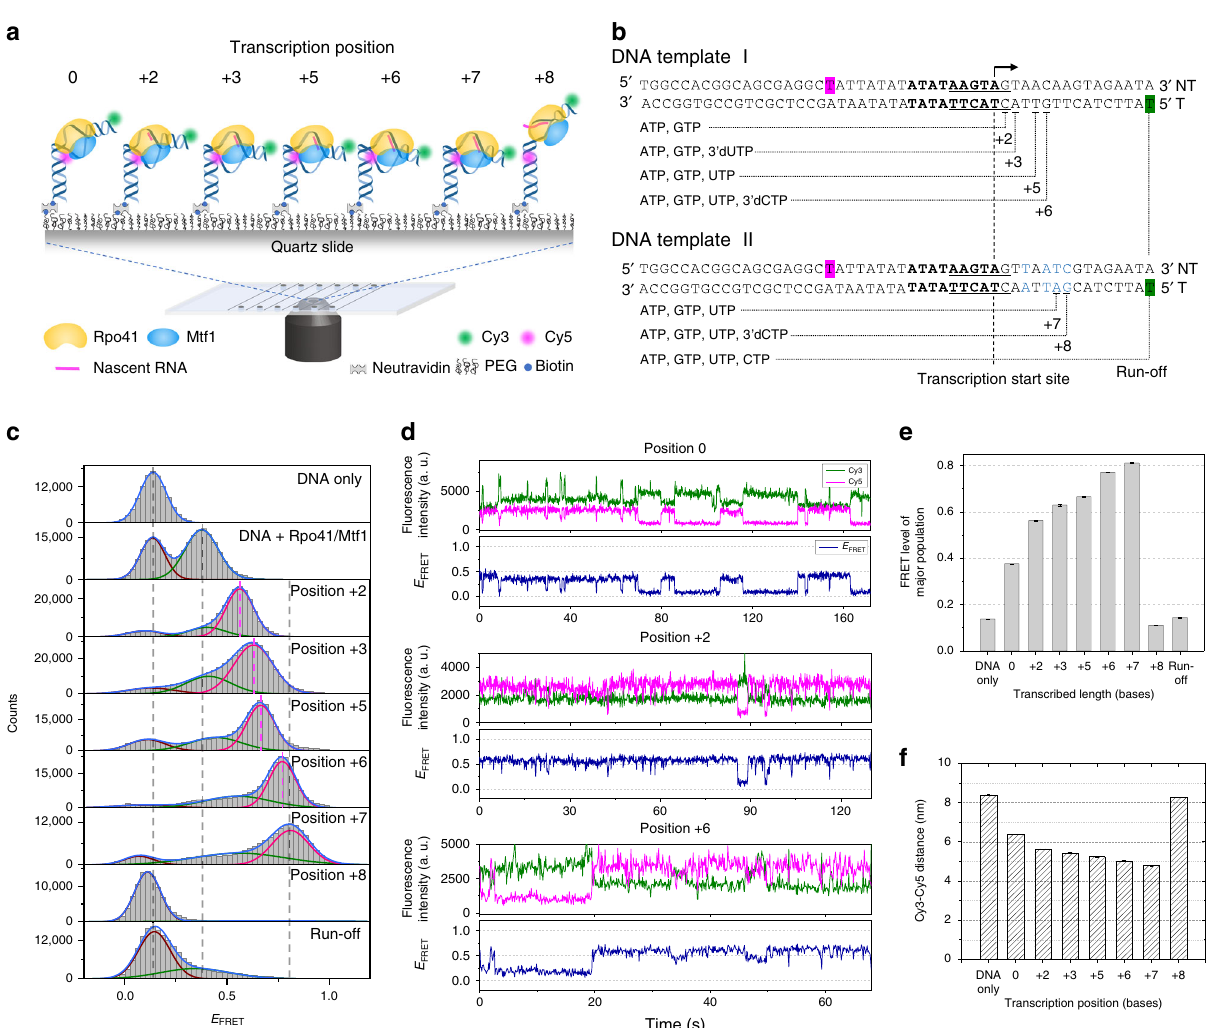
Fig. 1 Transcription initiation occurs through dynamic conformational changes. a Single-molecule measurements of transcription initiation dynamics. The dual-labeled DNA template complexed with Rpo41 and Mtf1 was observed using a total internal re fl ection fl uorescence microscope. b DNA templates used in base-pair-wise measurements of initiation complex dynamics. DNA template I could be stalled at positions + 2, + 3, + 5, and + 6, while DNA template II, which differed from DNA template I by four base-pairs (blue), could be stalled at positions + 7 and + 8. Both templates were labeled with Cy5 at position − 16 of the non-template strand (magenta) and Cy3 at position + 16 of template strand (green). The transcription promoter (underscored) and start site (arrow) are indicated. c FRET histograms from single-molecule traces with colocalized Cy3 and Cy5 signals at each stalling position. Histograms were fi t to single, double, or triple Gaussian peaks (Supplementary Table 1). The brown, green, and magenta curves represent low, mid, and high FRET populations, respectively. Dashed vertical lines mark the major FRET peaks of DNA only, DNA + Rpo41/Mtf1, and the complex at position + 7. Dashed lines in magenta mark the major FRET peaks at positions + 2, + 3, + 5, and + 6. d Representative smFRET traces at positions 0, + 2, and + 6 showing the Cy3 (green) and Cy5 (magenta) signals, and the FRET ef fi ciency traces (navy). e The FRET level of the major population in c shown for each stalling position as the center of the major Gaussian peak. The error bars represent the error in fi nding the peak center position from Gaussian fi tting. f The Cy3 – Cy5 distance at each stalling position calculated as the average between those obtained from DNA templates I/II ( e ) and I/II NT (Supplementary Fig. 5). Error bars represent the propagation of the errors in FRET